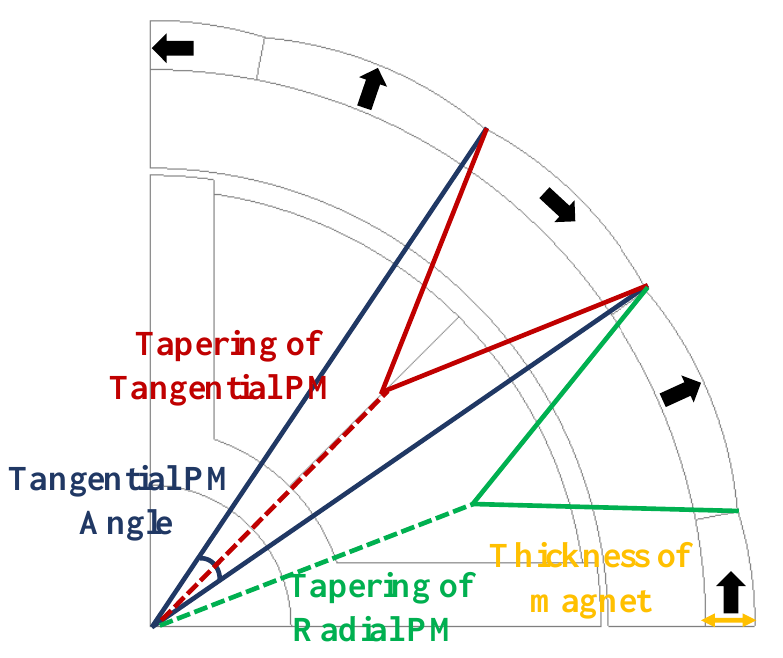
Figure 8. Geometric parameters of integrated magnetic bearing motor.